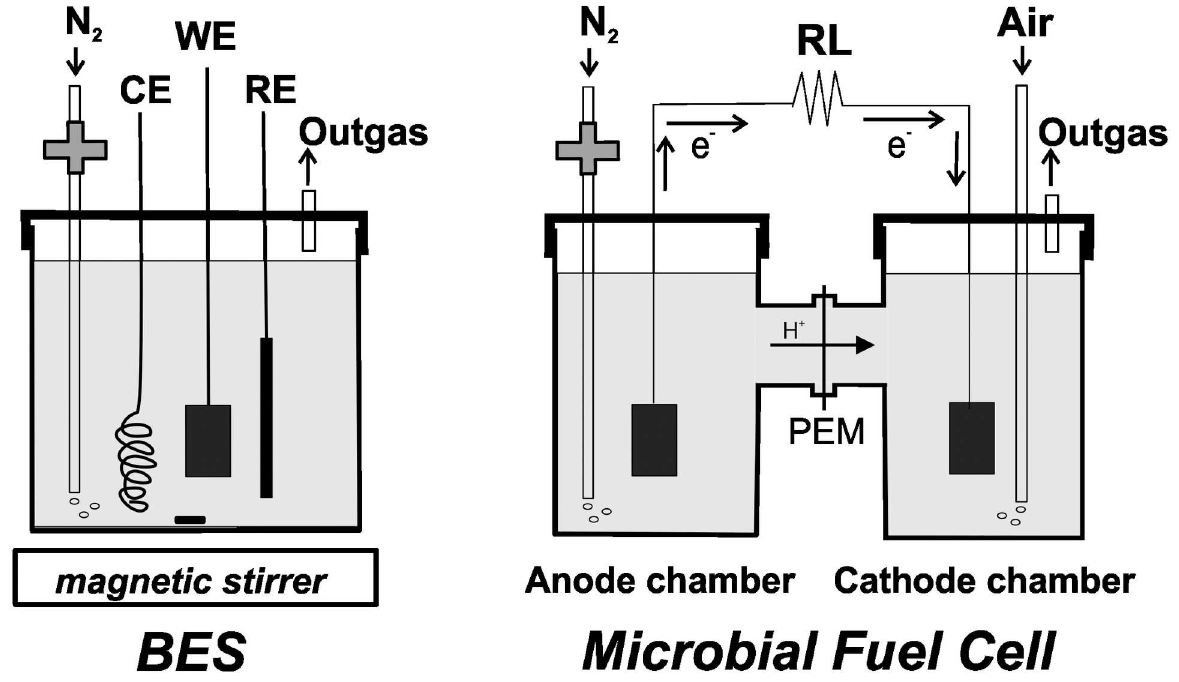
Fig 1. Schematic diagram of the bioelectrochemical set-up used in this work. In the denominated bioelectrochemical system (BES) a working electrode (WE) is coveredby a biofilm; CE and RE are immersed in the same solution (left). In the microbialfuel cell (MFC) the anodeand cathode compartments were separatedby a PEM (Nafion) membrane(right). N 2 was filtered by a 0.22 μ m membrane, as shown.